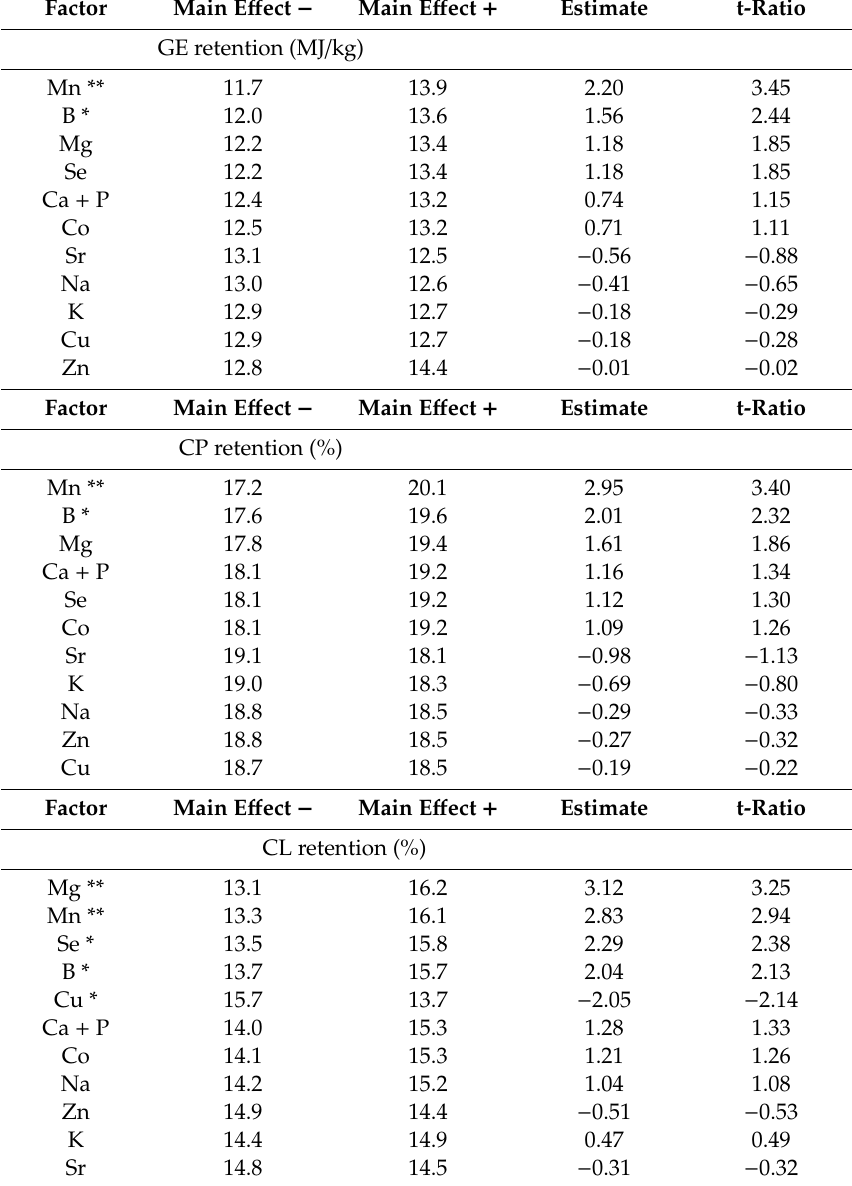
Table A4. E ff ect of twelve dietary minerals at two inclusion levels ( − /+ ) on GE retention, CP retention, CL retention, ash retention and total mineral retention of prawn body using two-level screening analysis. Factors are sorted by | estimates | and significant factors are marked by an asterisk (* p < 0.05, ** p < 0.01, *** p <